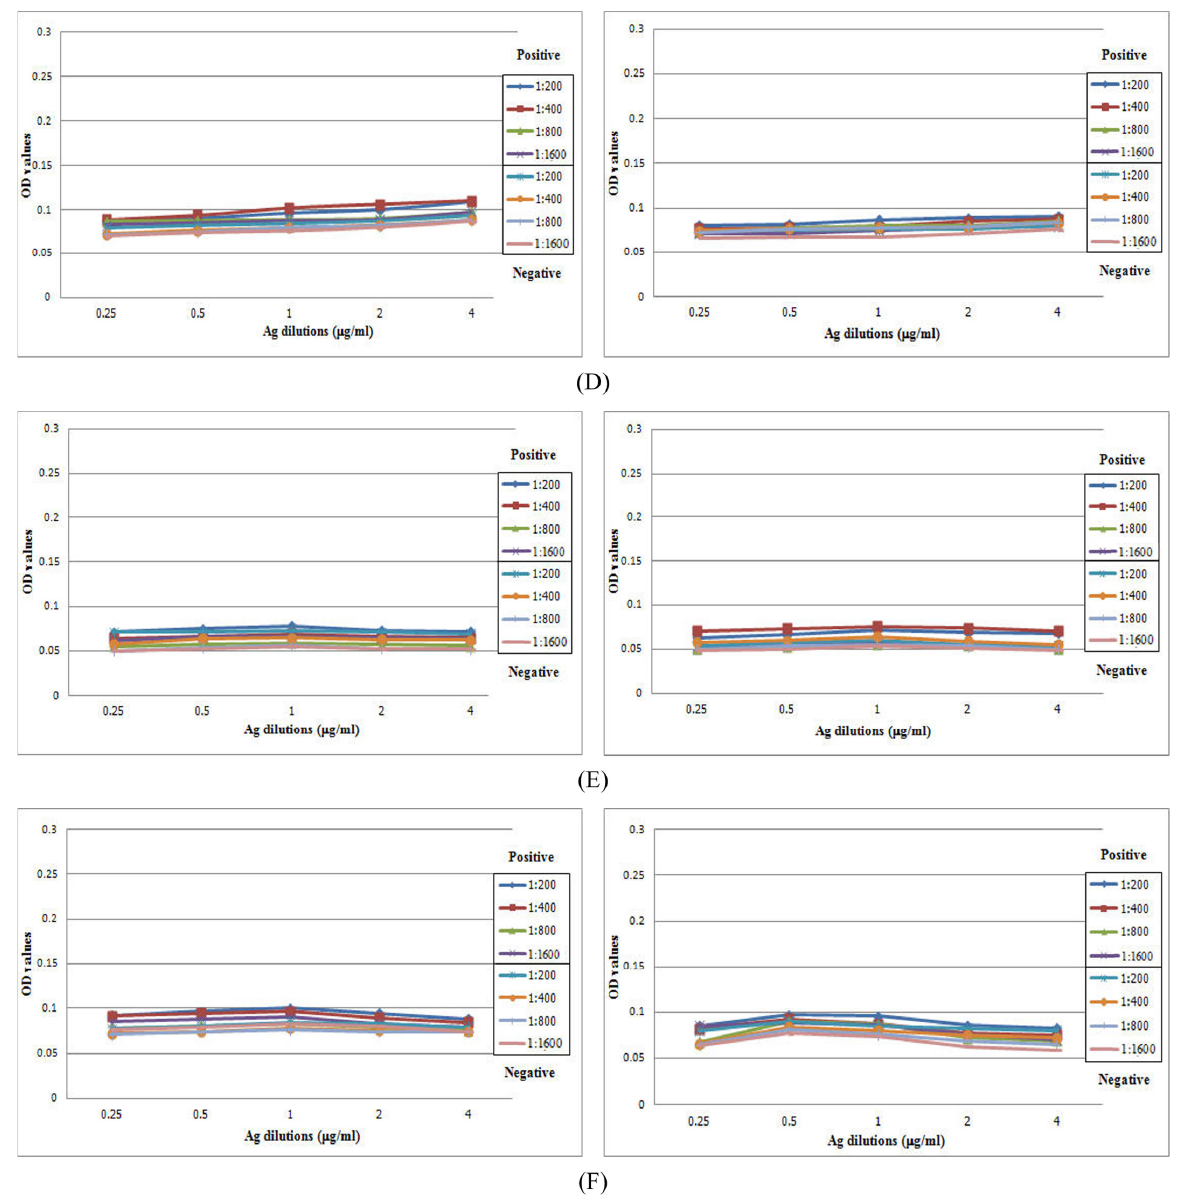
Figure 4. Checkerboard titration curves for determining the optimal concentration of A. caninum crude antigens (0.25–4 µg/mL) against various dilutions of pooled positive controls (PPC) and pooled negative controls (PNC) using 1:2000 (L, Left) and 1:4000 (R, Right) dilutions of peroxidase-conjugated anti-human IgGs (( A ): IgG, ( B ): IgG 1 , ( C ): IgG 2 , ( D ): IgG 3 , ( E ): IgG 4 , and ( F ): IgE). Lines represent OD values of dilutions of either pooled positive serum or pooled negative serum at ratios of 1:200, 1:400, 1:800, and 1:1600.